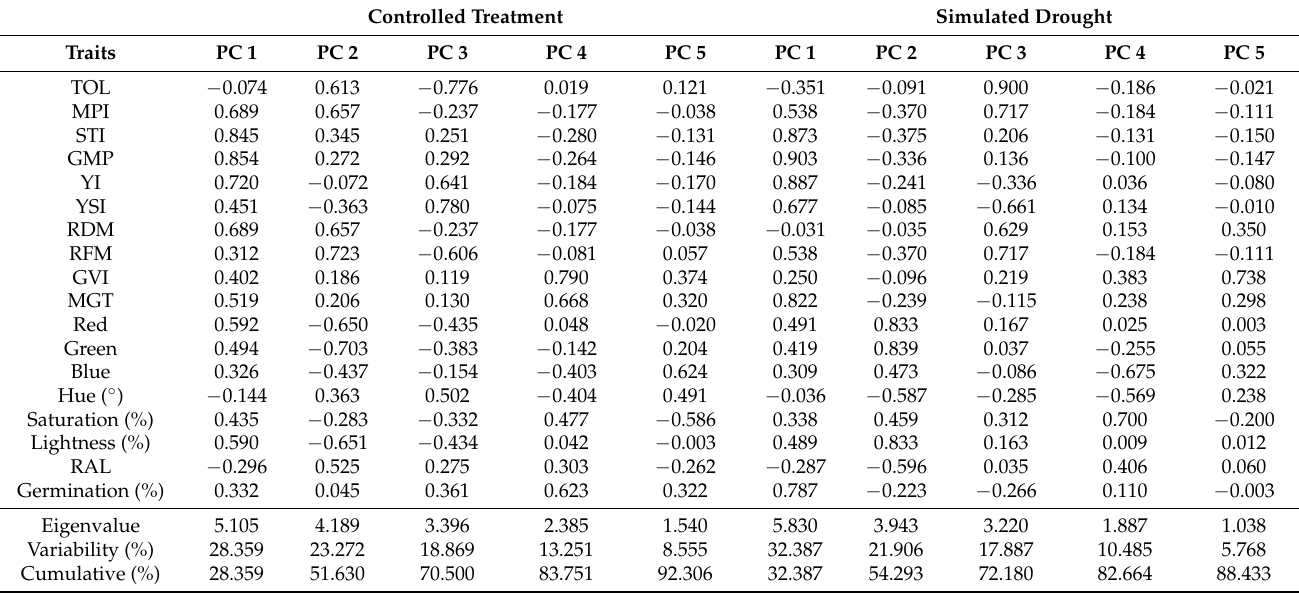
Table 5. Summary of factor loadings, eigenvalues, Kaiser-Meyer-Olkin measure of sampling